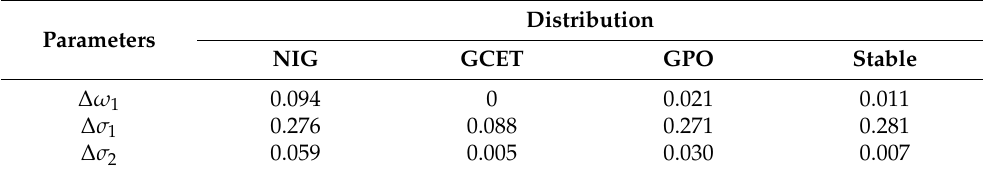
Table 5. Additive bias values to be compensated.